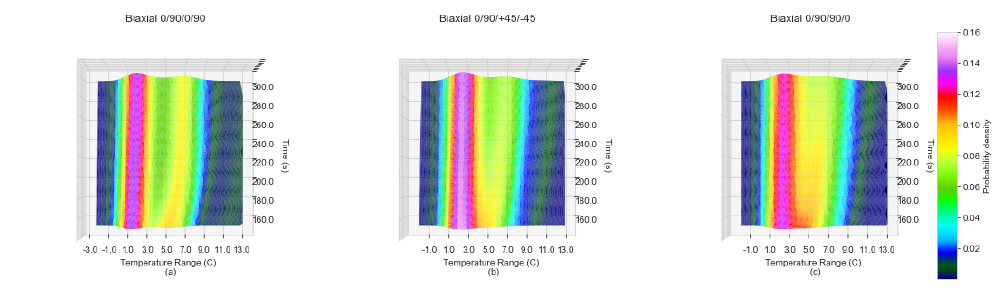
Figure 4. Kernel density estimates top down view of laminate samples for temperature changes ranges − 3 ◦ to 12 ◦ for the time period 150 to 300 s ( a ) Biaxial 0/90/0/90, non symmetrical and balanced, ( b ) Biaxial 0/90/+45/ − 45, non symmetrical and unbalanced, ( c ) Biaxial 0/90/90/0, symmetrical and